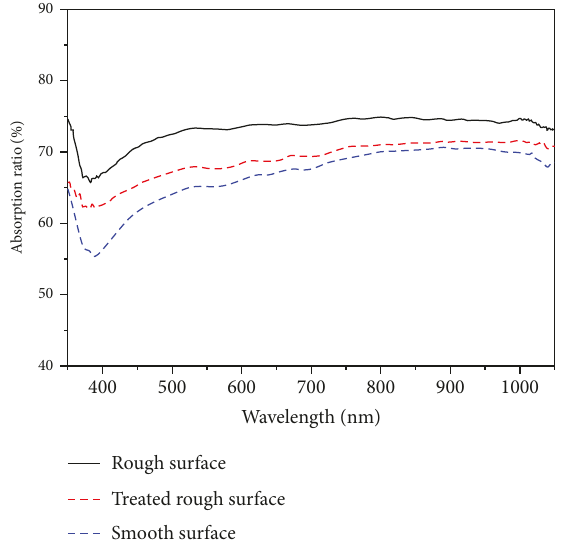
Figure 16: Absorption spectrum for three